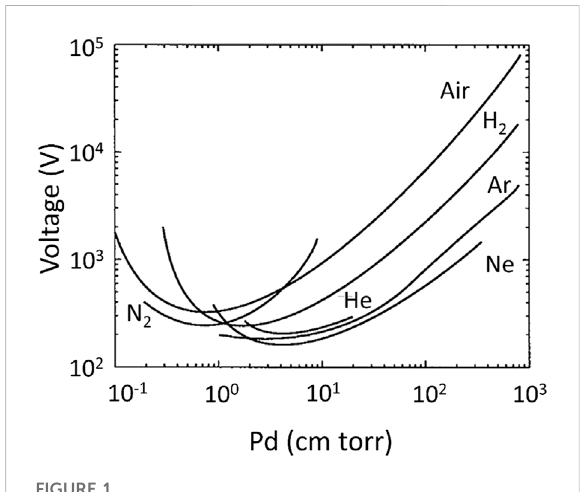
FIGURE 1 Paschen curves of different gases for plane parallel